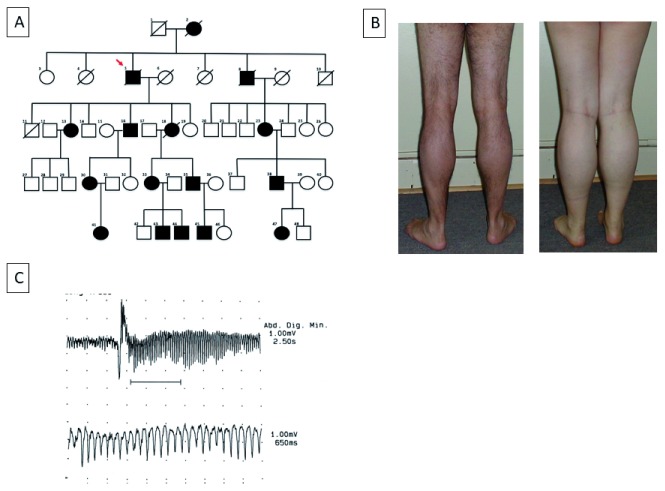
(
A) Genogram of Family. Red arrow indicates index case. (
B) Calf hypertrophy in a male (case A:16) and female (case A:30). (
C) EMG showing myotonic activity exacerbated by needle movement from case A:30.